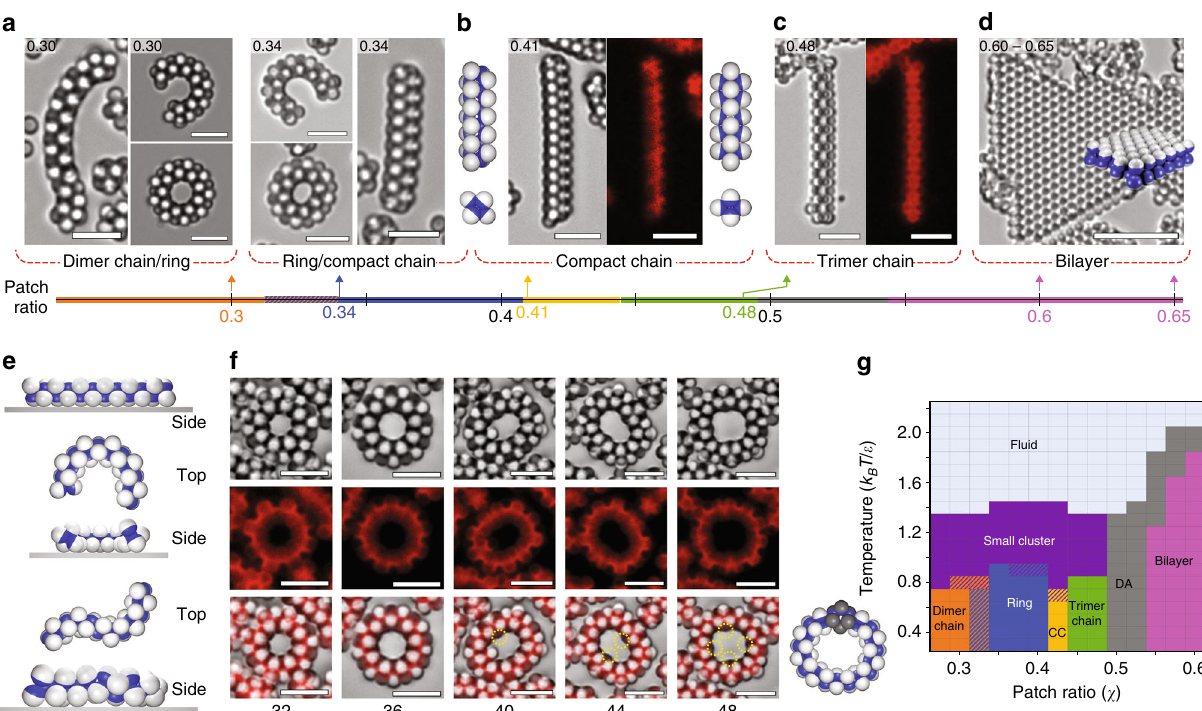
Fig. 5 DNA-mediated self-assembly of Janus particles in the presence of depletion force. a – c Optical microscope images for self-assembled structures of DNA-coated Janus particles with various patch ratios between χ = 0.3 and 0.65 in the presence of 1% of F127, which forms micelles and introduces a weak attractive depletion interaction. a When χ = 0.3, particles self-assemble into dimer chains as well as ring structures, which form only when there is a depletion interaction. b For χ = 0.34, the same structures are observed, as well as densely-packed chains which we call compact chains (CC). For χ = 0.41, most chains are compact chains. c However, the structures of trimer chains ( χ = 0.48) and d bilayers ( χ = 0.6 and 0.65) are unchanged. e Half of the particles of a dimer chain can touch the substrate if the chain is straight (top) or has a constant radius of curvature (middle). However, when the dimer chain curvature is not constant, as for an S-shaped chain (bottom), one or more particles in the chain detach from a fl at substrate. f Bright fi eld (top) and fl uorescent (middle) optical microscope images of rings consisting of 32 – 48 particles. Yellow dashed circles in bright fi eld/ fl uorescent overlay (bottom) show the locations octahedral defects that appear for χ = 0.34. Illustration on the right shows the structure of a single octahedral defect. g Phase diagram of Janus particles obtained by simulation in the presence of a depletion interaction ( ε dep =